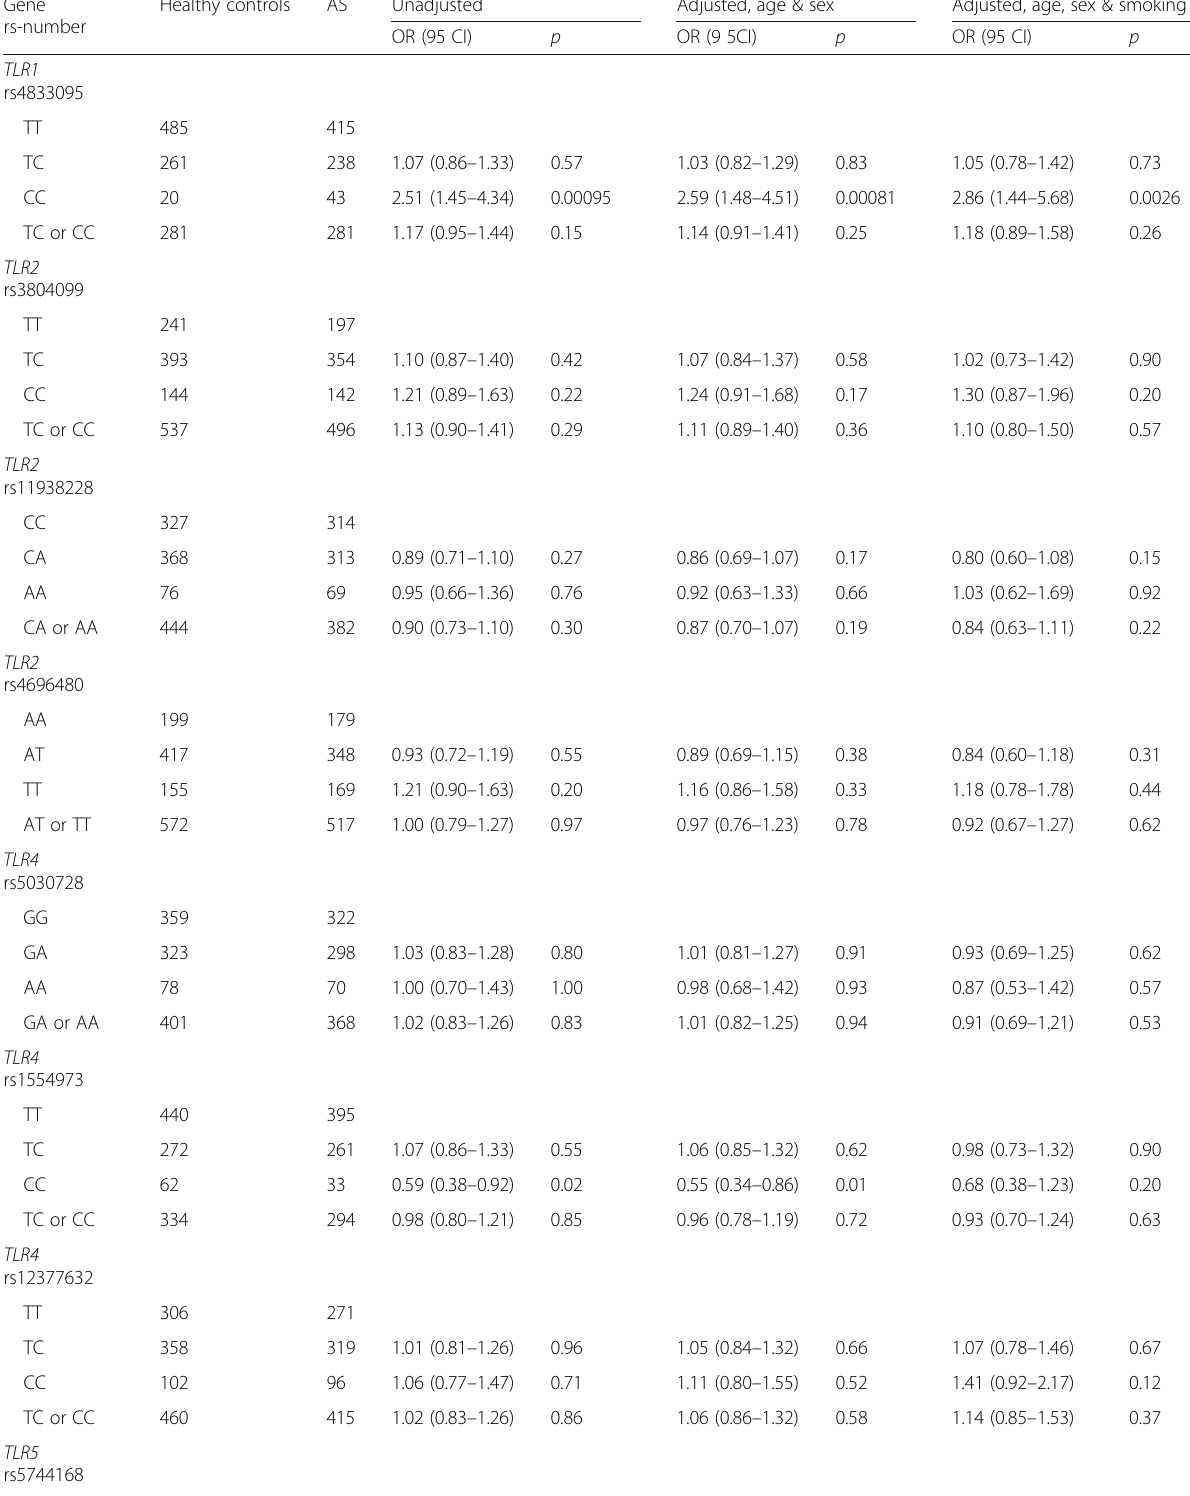
Table 1 Odds ratios (OR) and 95% confidence interval (95CI) for genotypes studied among healthy controls and patients with ankylosing spondylitis